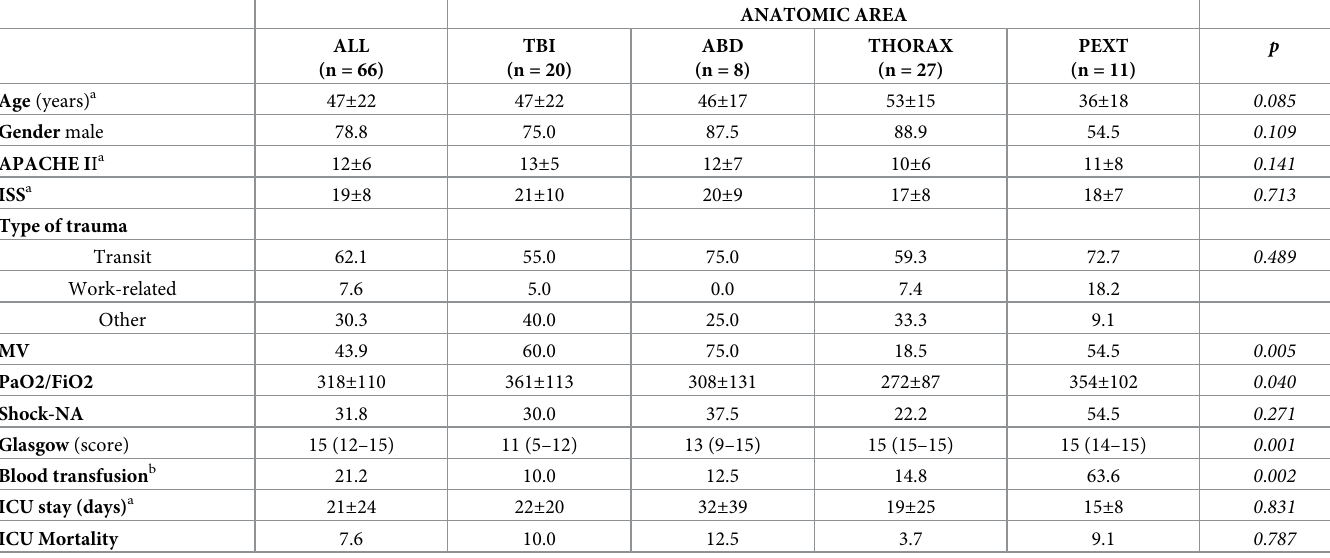
Table 1. Study population characteristics of trauma patients (according anatomic location).